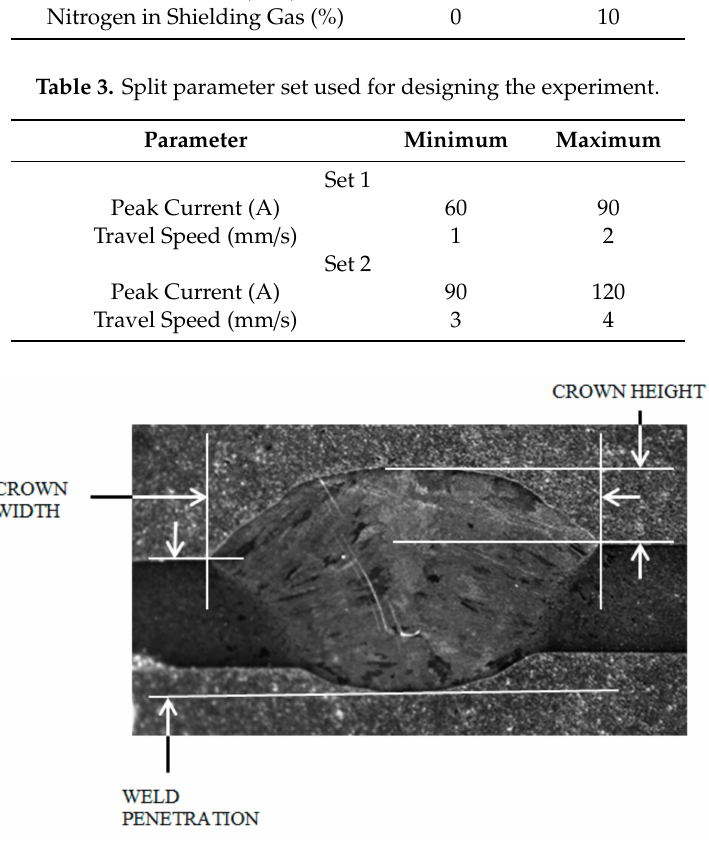
Figure 1. Output parameters considered to quantify bead